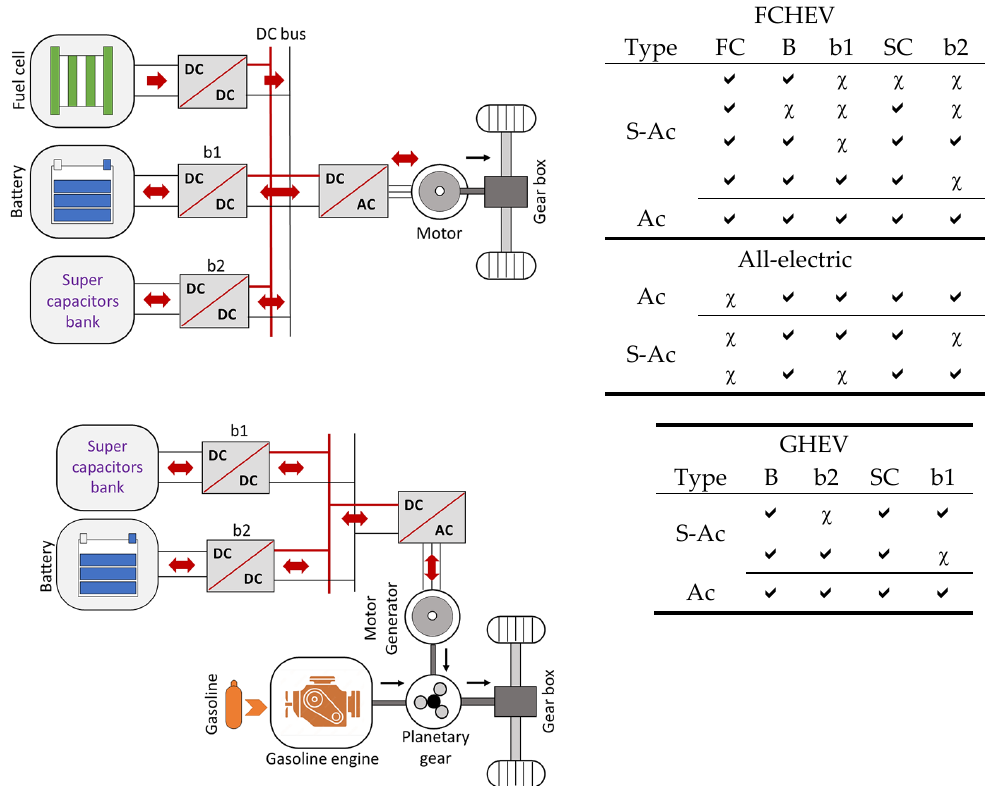
Figure 3. Powertrain configurations of electrified automobiles. ( a ) r-HEV (Nissan e-Power, etc.). ( b ) BEV (Renault Zoe, etc.). ( c ) GHEV (Toyota Prius, etc.). ( d ) FCHEV (Toyota Mirai, etc.). Legend: S-Ac (semi/active), FC (fuel cell), B (battery), SC (supercap), b12 (converters).